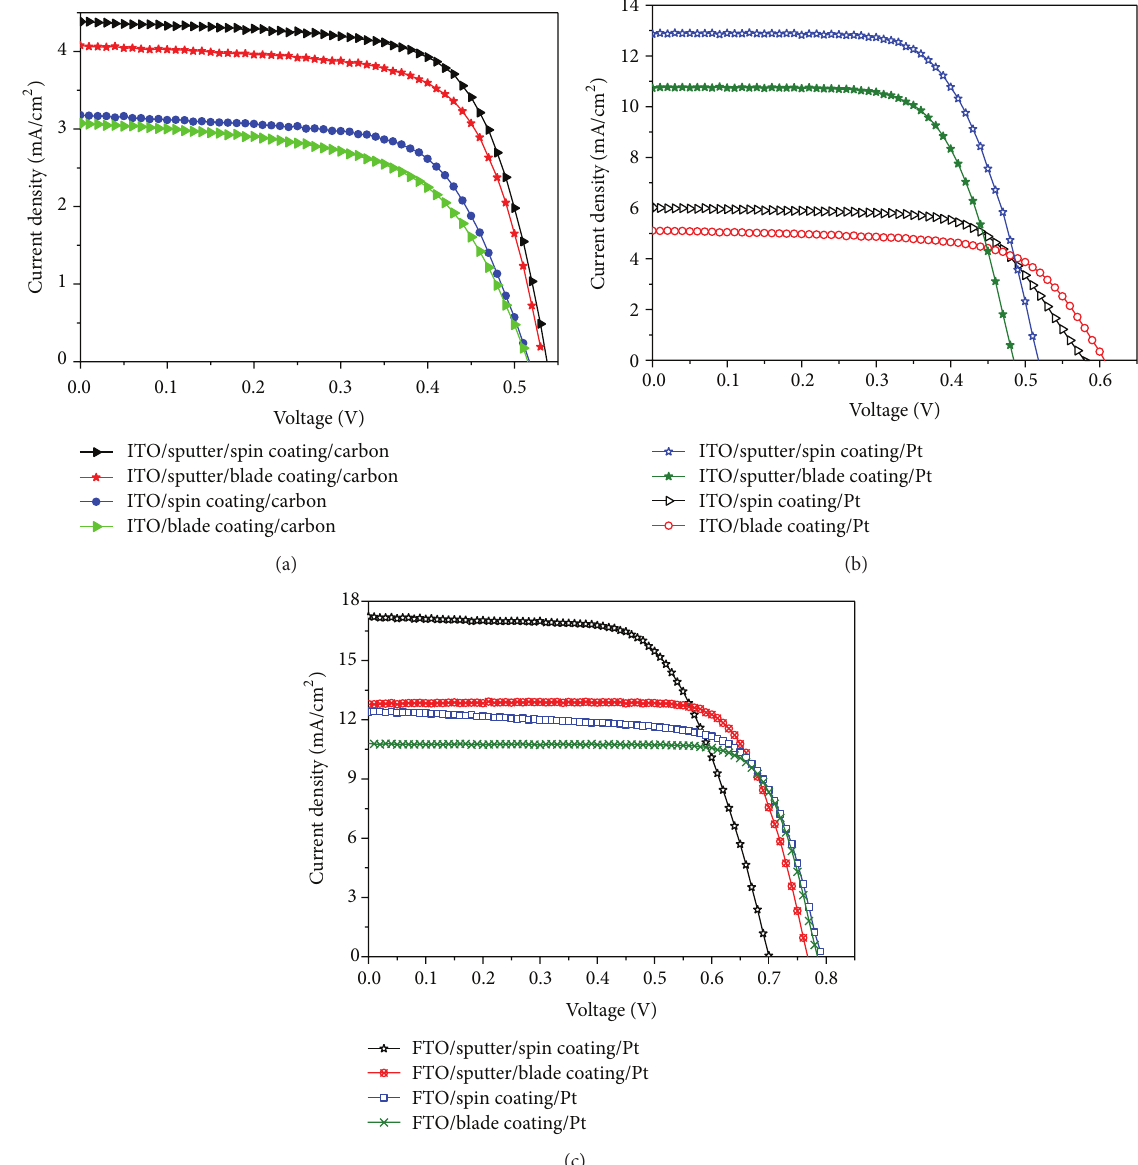
Figure 6: The 𝐼 - 𝑉 characteristics for DSSCs fabricated with and without a TiO 2 compact layer, (a) using a carbon counter electrode and ITO/glass, (b) using a Pt counter electrode and ITO/glass, and (c) using a Pt counter electrode and FTO/glass, under AM 1.5 solar irradiation with a density of 100 mW/cm 2